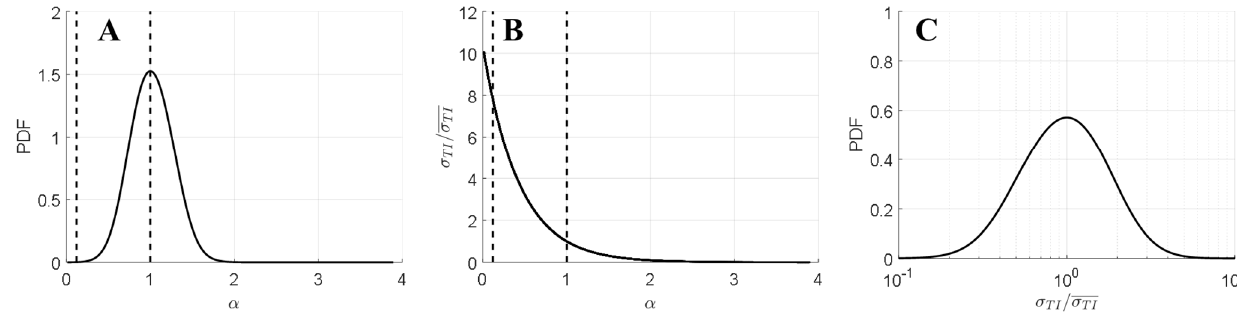
Figure 6. Illustration of multi-fractal model; ( A ) Bałdyga and Bourne’s [70] suggestion for the PDF of the eddy labelling dimension α ; ( B ) the instantaneous stress normalized to its time-averaged value (Equation (18)), as a function of the labelling dimension α ; ( C ) the resulting PDF of disruptive stress, obtained by combining ( A , B ).